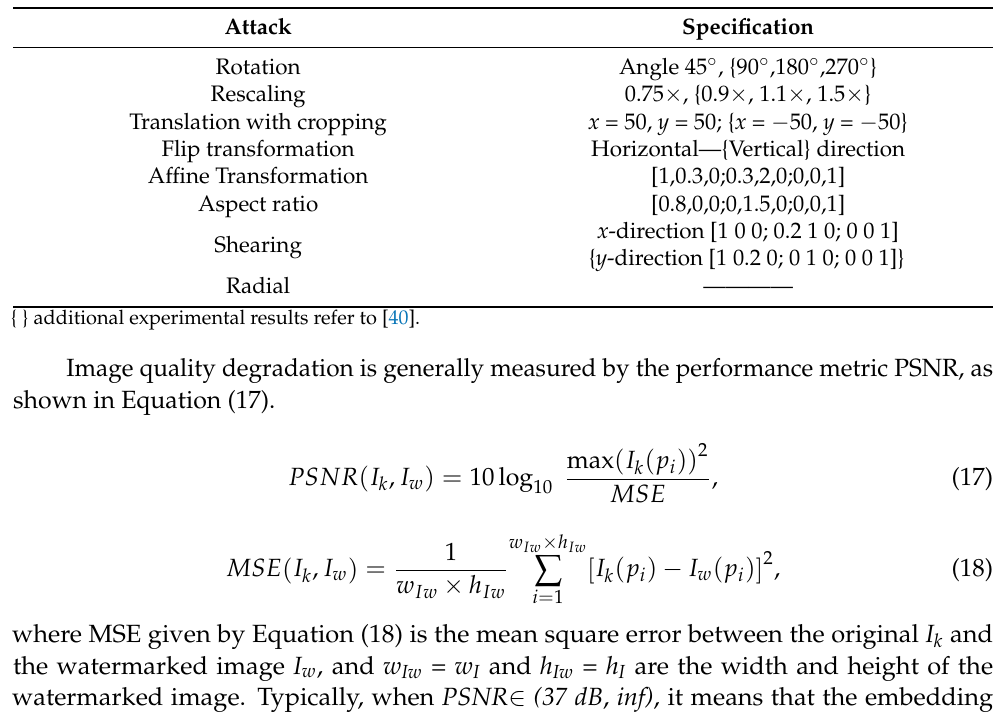
Table 2. Common geometric attacks used in the